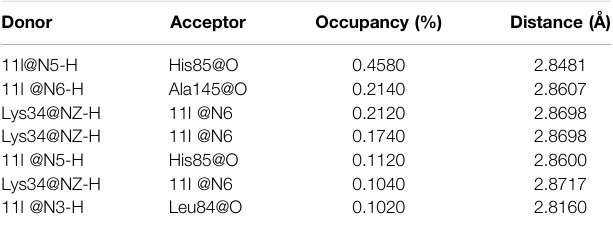
TABLE 3 | Statistical analysis of the hydrogen bond interactions between 11l and CDK2 during MD